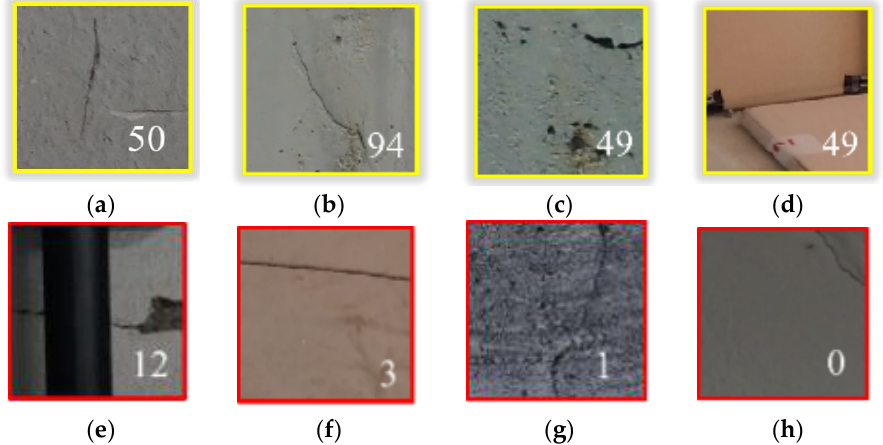
Figure 11. Example images of FP groups ( a – d ), FN groups ( e – h ) and their crack probabilities ( a – d ): ( a ) crack-shaped contaminants; ( b ) overlaid cement paste; ( c ) continuously distributed concrete pores; and ( d ) edge of linear-shaped construction material; ( e ) crack hidden behind object; ( f ) crack having straight line; ( g ) crack obscured by dark surface; and ( h ) crack on the corner of detecting window.